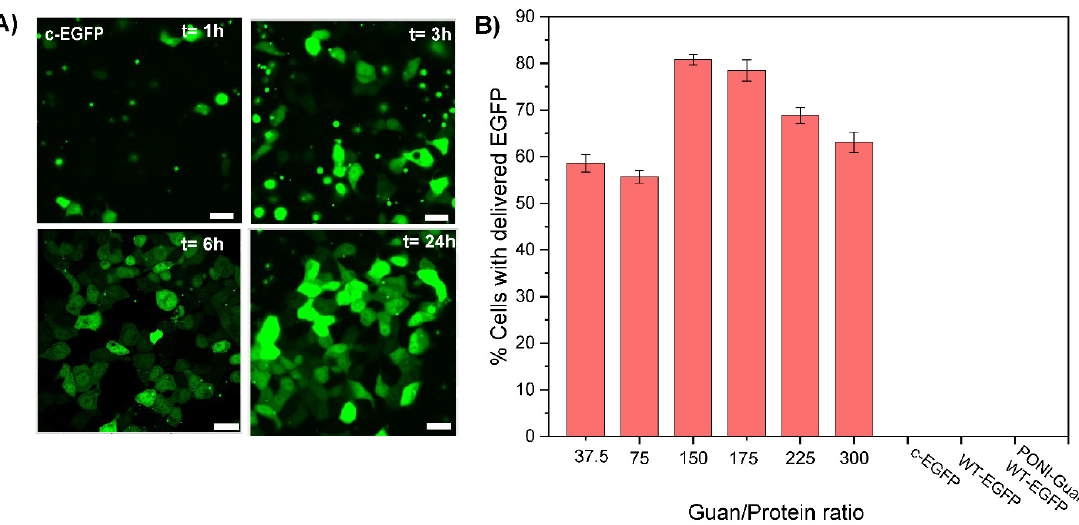
Figure 2. Representative confocal images of HEK-293T and quantification of delivery by flow imaging cytometry after 24 h incubation with PONI Guan/c-EGFP assemblies. ( A ) Delivery of c-EGFP delivery formulated at Guan/Protein ratio 150 (scale bar: 25 μ m) at different time points. Diffuse fluorescence and nuclear access, where appropriate, signals cytosolic access. ( B ) Quantification of the percentage of cells delivered with EGFP at different Guan/Protein ratios. Data are an average of replicate measurements (n = 3). Error is the standard deviation by population.